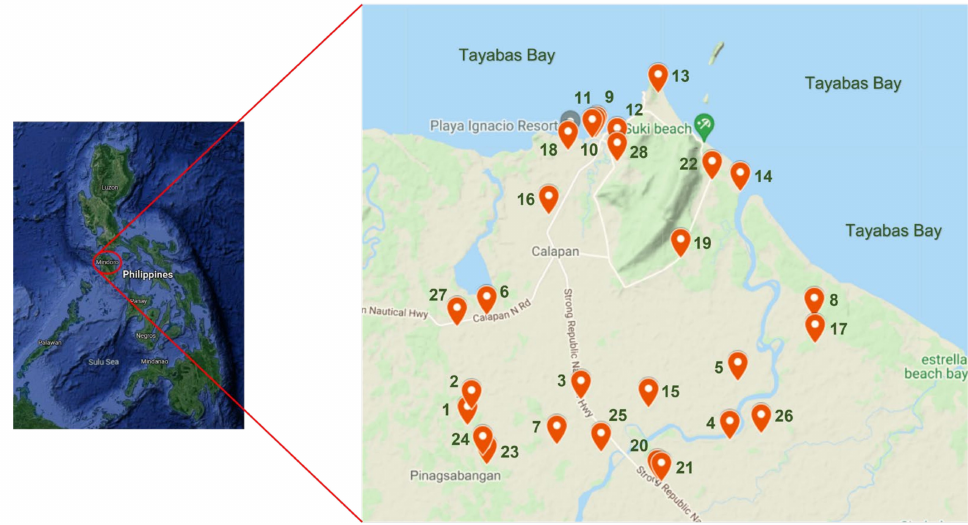
Figure 2. Map of the Study Area and Sampling